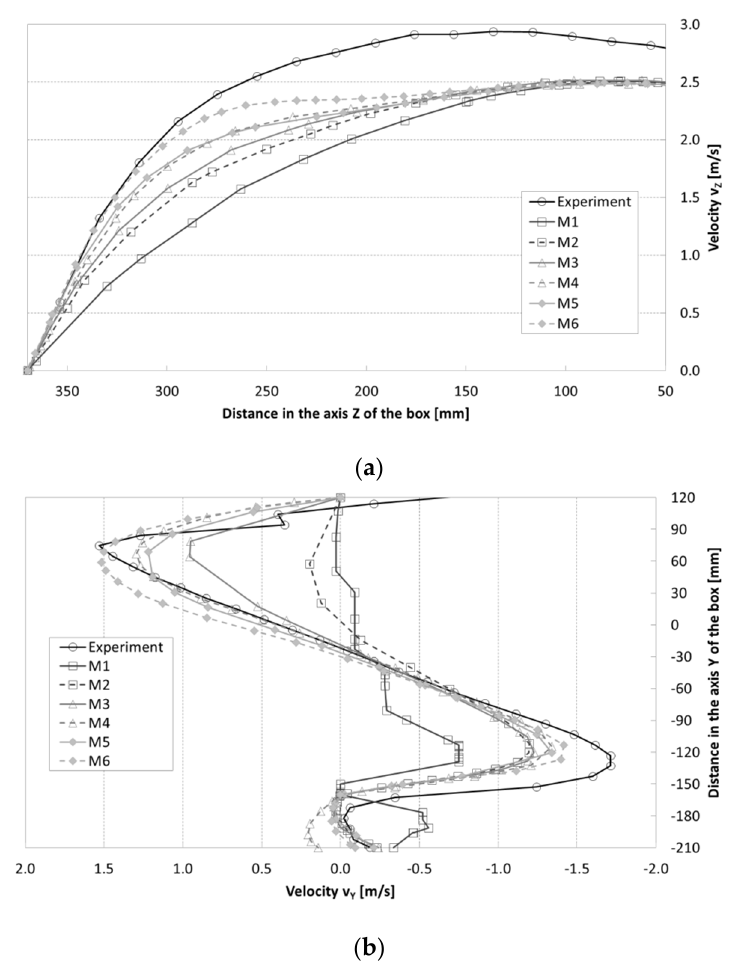
Figure 11. Distribution of velocity components in plenum box with side entry ( a ) in the Z direction for Y = 0 mm; ( b ) in the Y direction for Z = 350 mm.